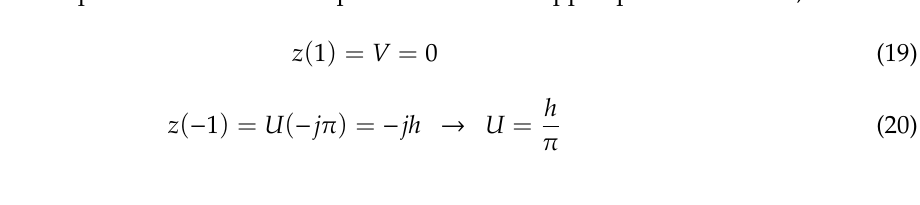
Table 2. Mapped points between the z -plane and t -plane in Region 3. Symbol z -Plane